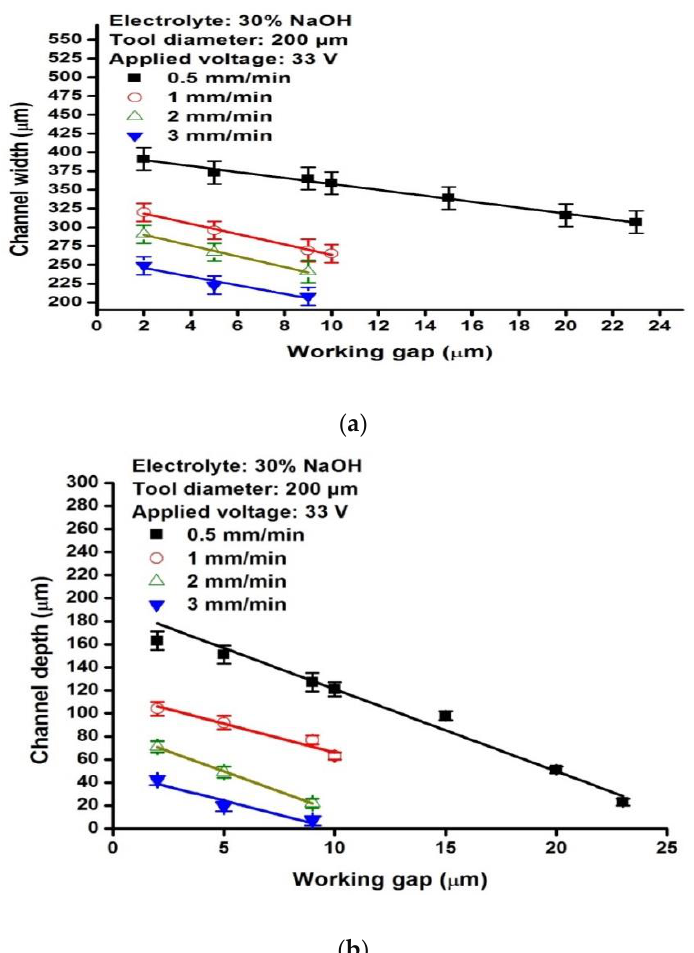
Figure 6. Variation of channel ( a ) depth and ( b ) width with increasing working gap for micro-chan- nels fabricated with a machining voltage of 33 V for different tool travel rates of 0.3 mm/min, 0.5 mm/min, 1 mm/min, 2 mm/min and 3